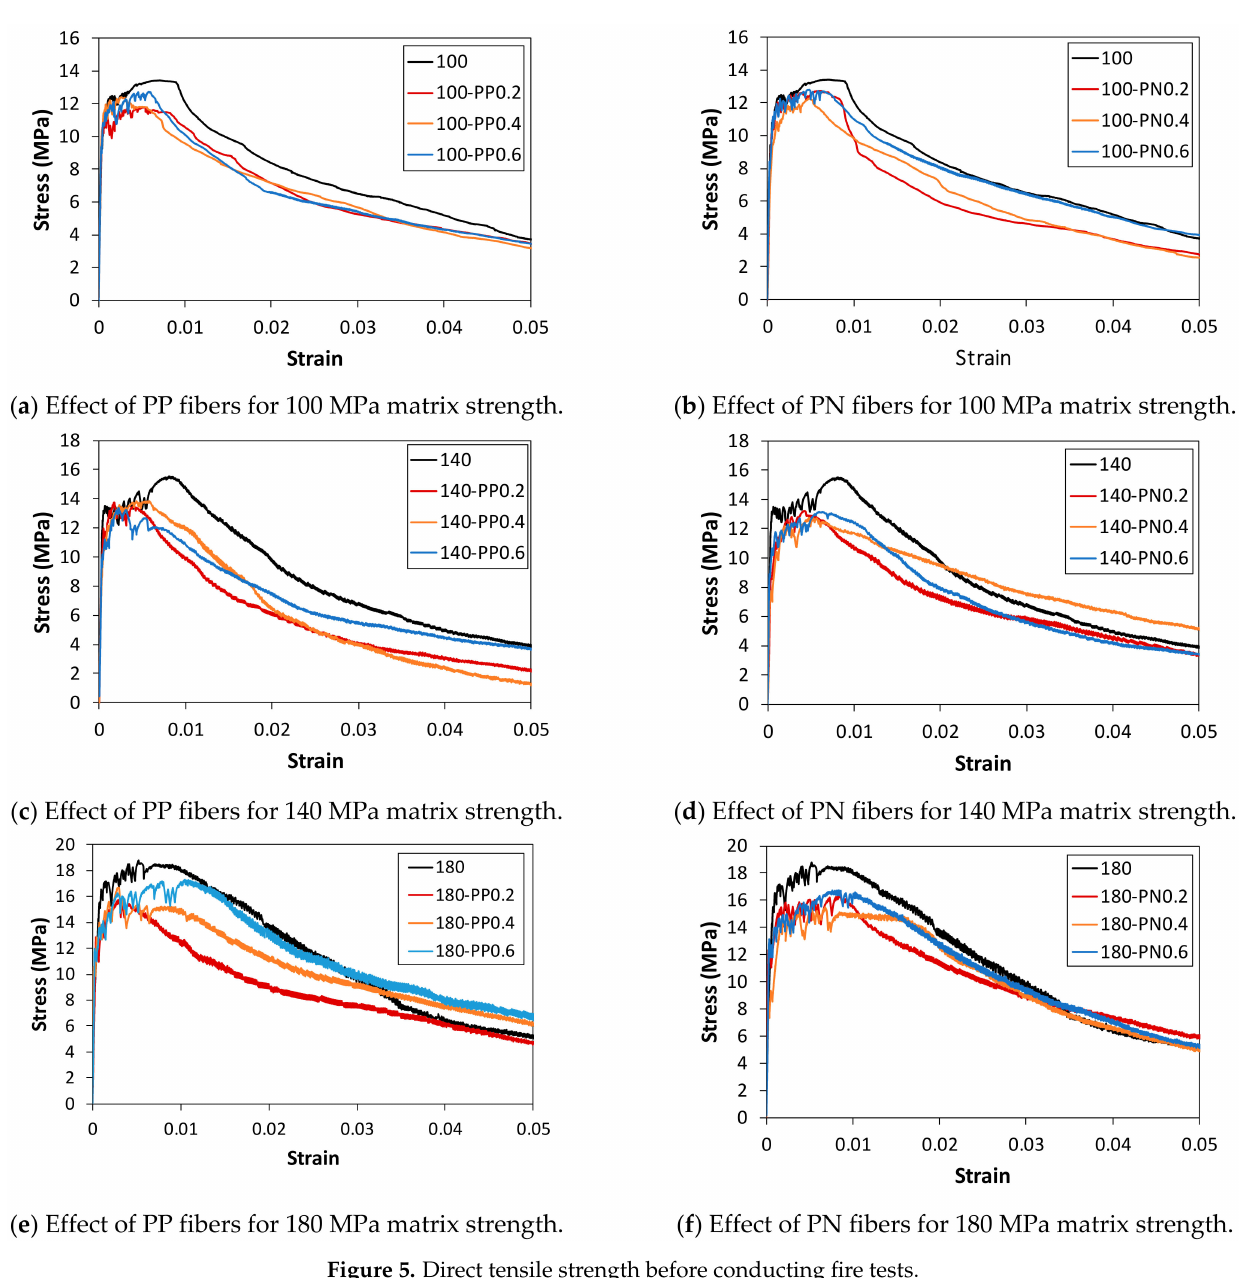
Figure 5. Direct tensile strength before conducting fire